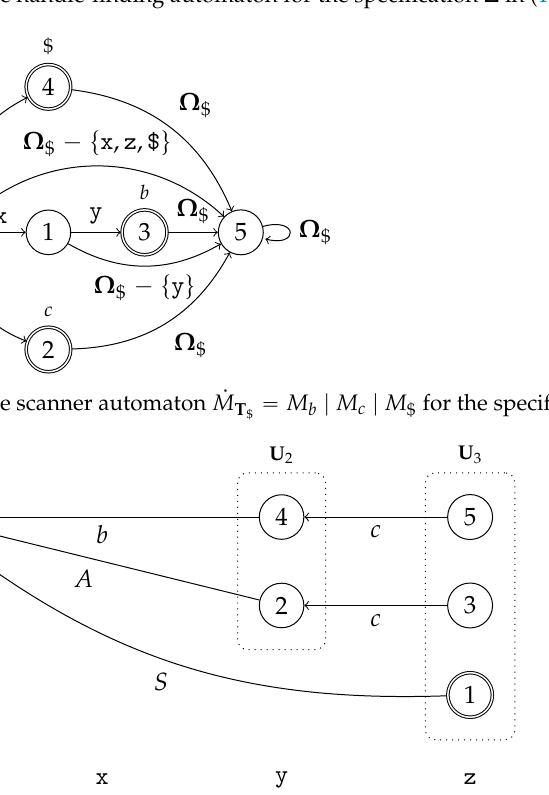
Figure 3. The GSS constructed by the traditional parsing architecture using the specification Ξ in